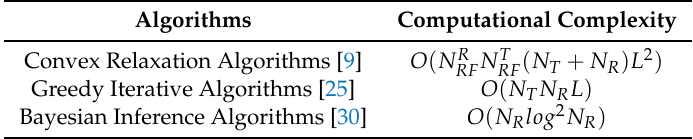
Table 1. Computational complexity comparison of the three categories of